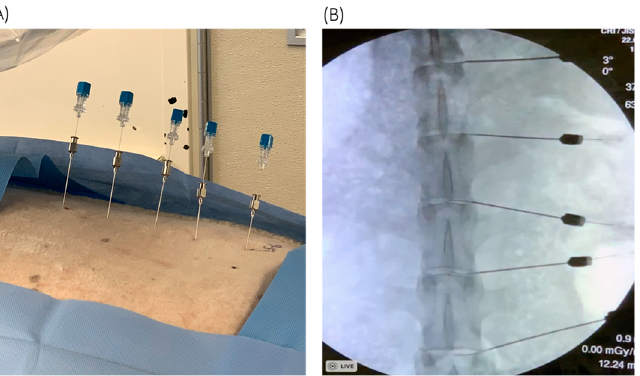
Figure 1. ( A ) 25-gauge needles within the 20-gauge introducer needles, serially spaced into the lumbar discs. ( B ) Fluoroscopic radiograph verifying needle placement in the AP plane. discs. ( B ) Fluoroscopic radiograph verifying needle placement in the AP